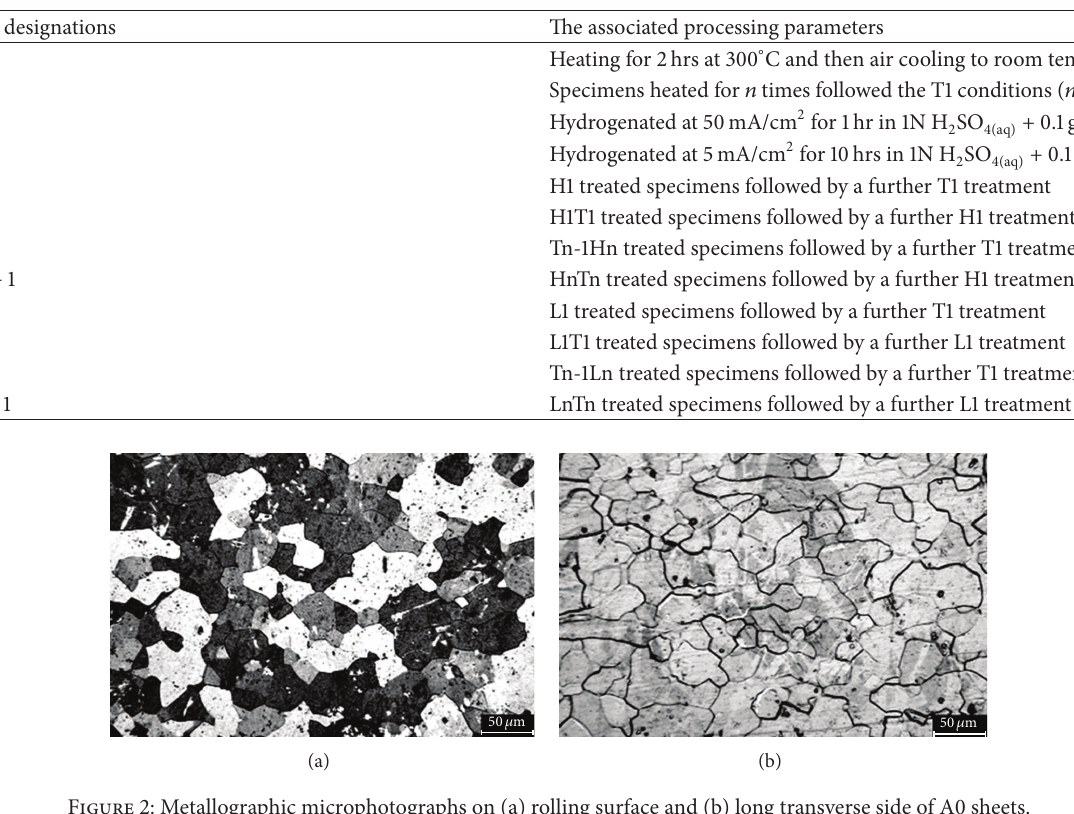
Figure 2: Metallographic microphotographs on (a) rolling surface and (b) long transverse side of A0 sheets.